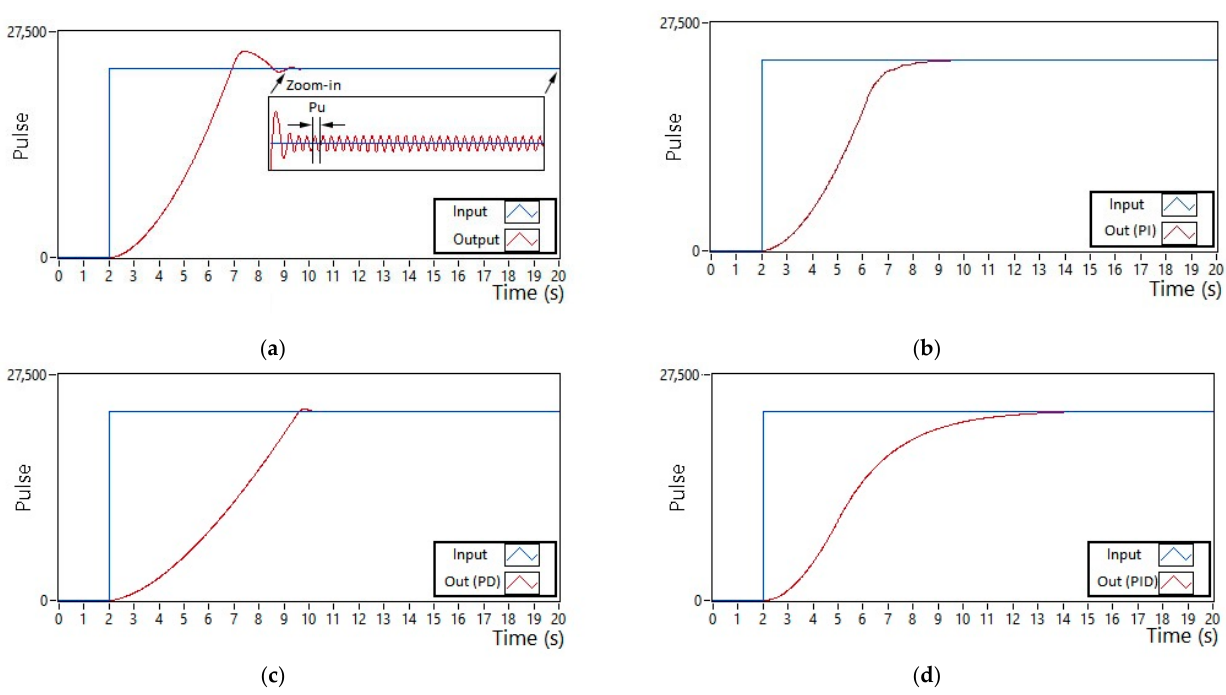
Figure 9. Result of motor control system. ( a ) Oscillation output; ( b ) PI; ( c ) PD; and ( d )